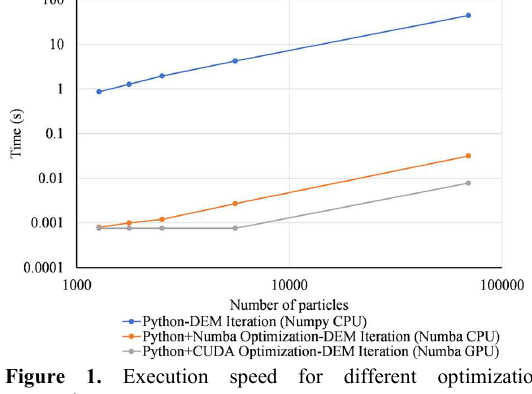
Figure 1. Execution speed for different optimization approaches.